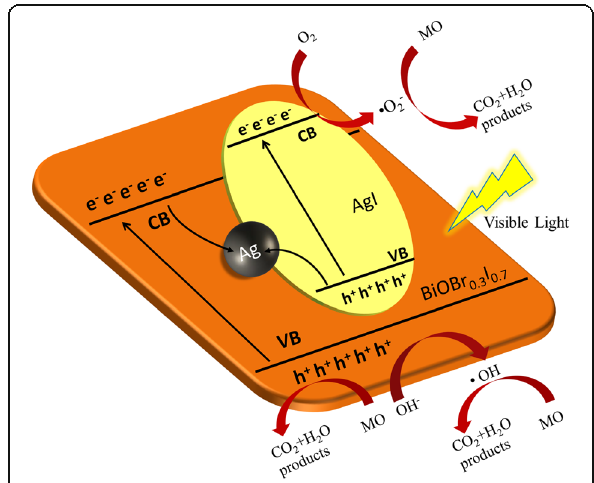
Fig. 6 Schematic of the mechanism of the photodegradation of MO by BAA-